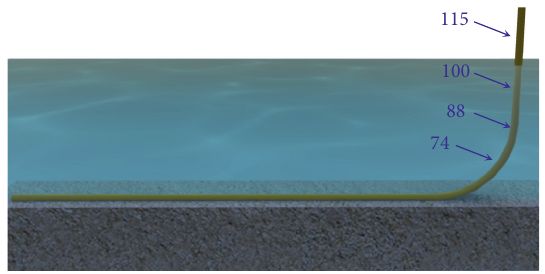
Figure 15: : Position of the PTMD.